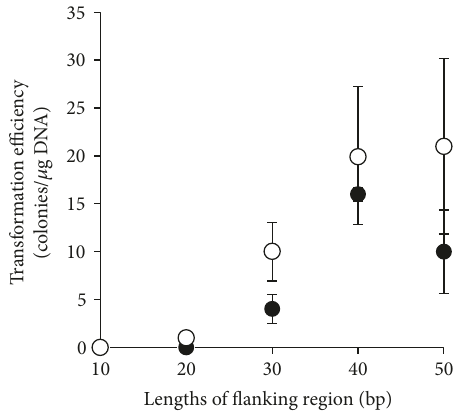
Figure 3: E ff ects of length of the fl anking homologous region on transformation e ffi ciency. SK-1 was transformed with 1 μ g of a linear marker cassette attached to fl anking regions (10 – 50bp) of various lengths at both ends. The resulting colonies were counted. Open circles: regeneration in MBS; closed circles: direct plating (no regeneration). Error bars represent the standard deviation of three independent